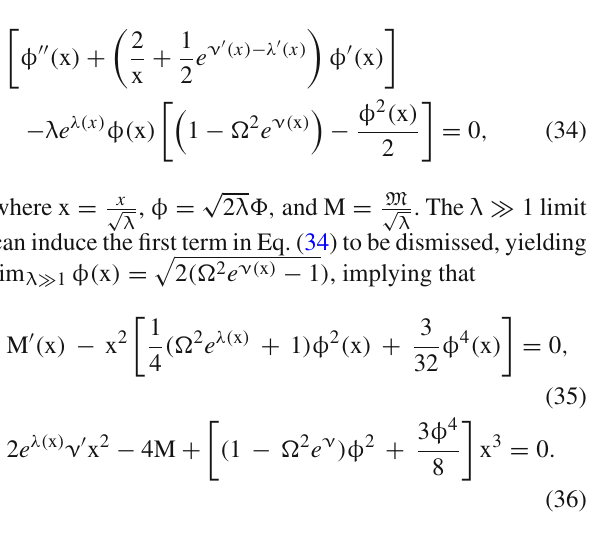
and (cid:9) = ω . The glueball m m 2